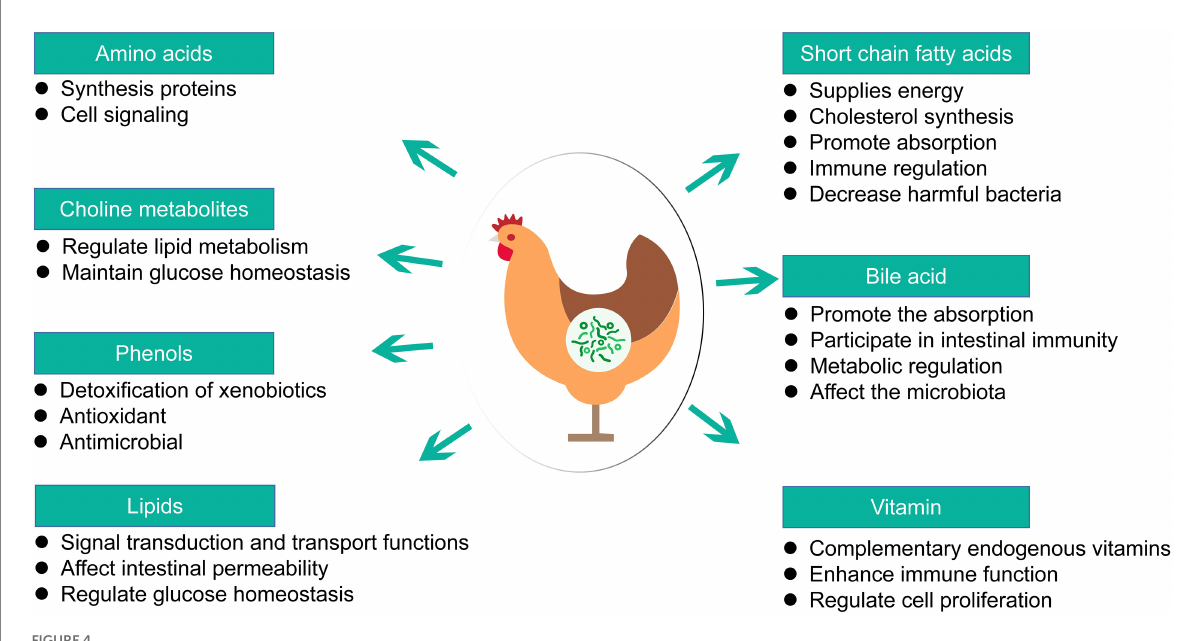
FIGURE 4 Overview of beneficial functions of metabolites produced by probiotics in poultry